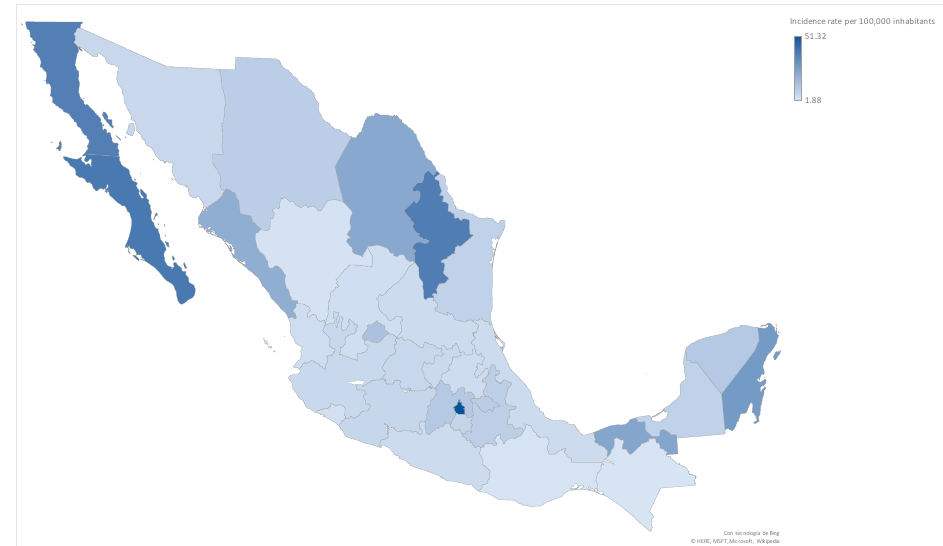
Figure A1. COVID-19 Incidence by state in Mexico through Phase 1 and 2, 2020 ( n = 969 by state-clusters). COVID-19 incidence by state in Mexico, in which the color is adjusted depending on the rate per 100,000 inhabitants. The states with the highest incidence rate were Mexico City and Baja California Sur.